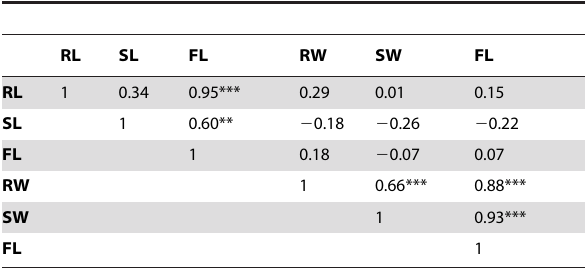
Table 7. Correlation coefficients ( r ) between WTC of pairs of traits of seedlings at seedling stage after